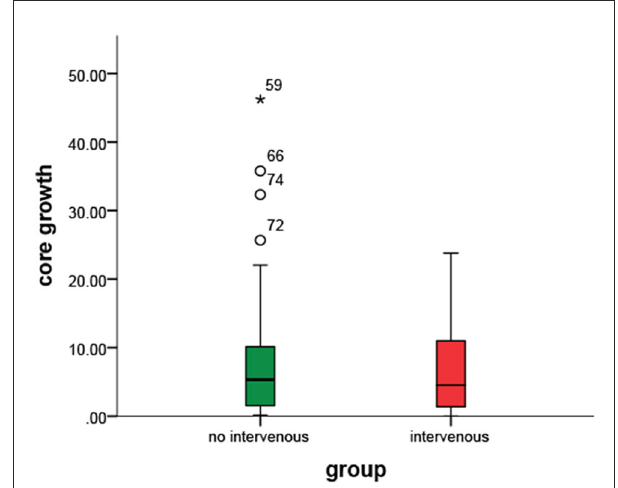
FIGURE3 No clear difference was observed in the core growth rate between the two groups.